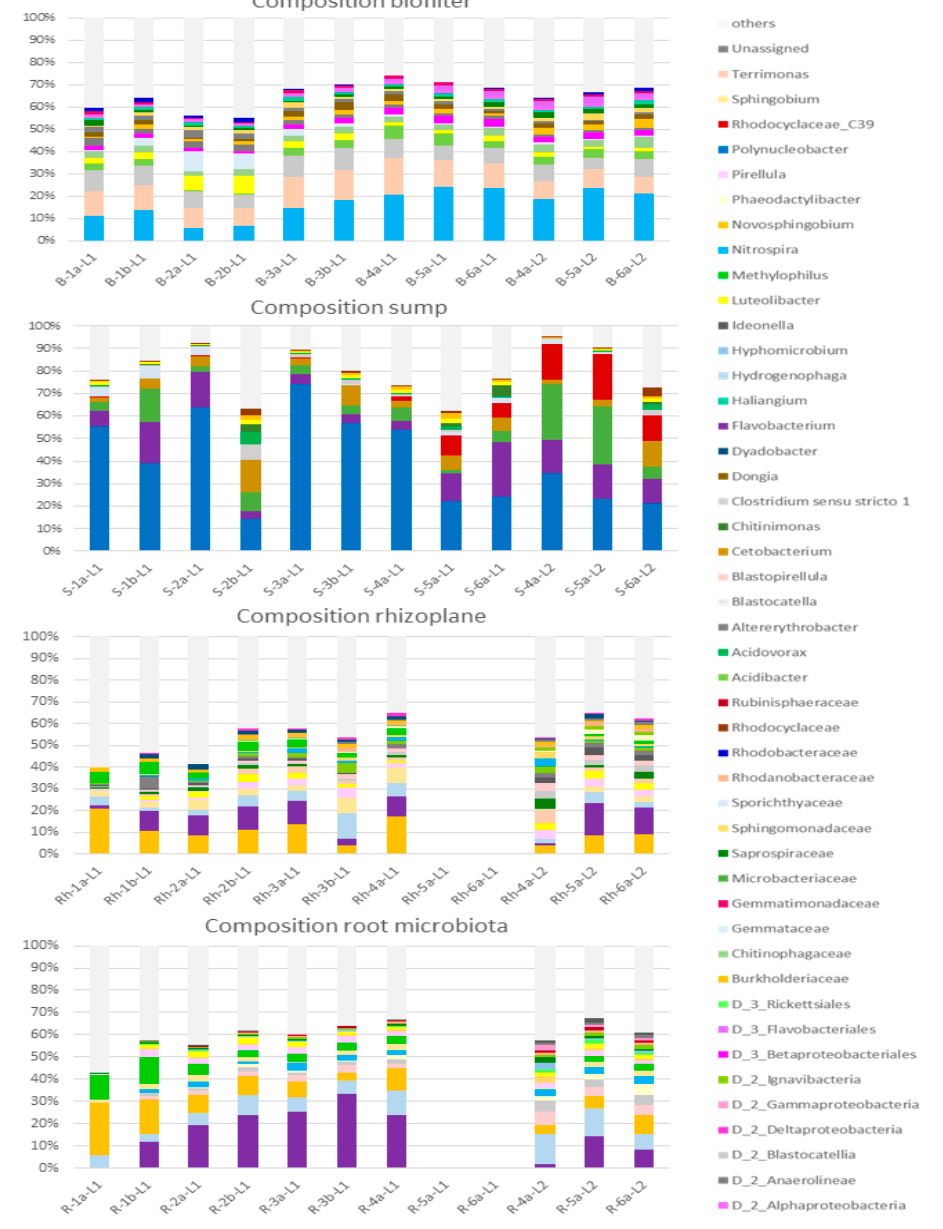
Figure 5. Barplots representing the relative abundances of the taxa representing more than 1% (in average) of each of the four compartments. The taxa representing less than 1% are gathered in the “others” group. In the legend, taxa are classified by taxonomic level and alphabetical order. The Rh-5a-L1, Rh-6a-L1, R-5a-L1 and R-6a-L1 were discarded as the lettuces presented disease symptoms.